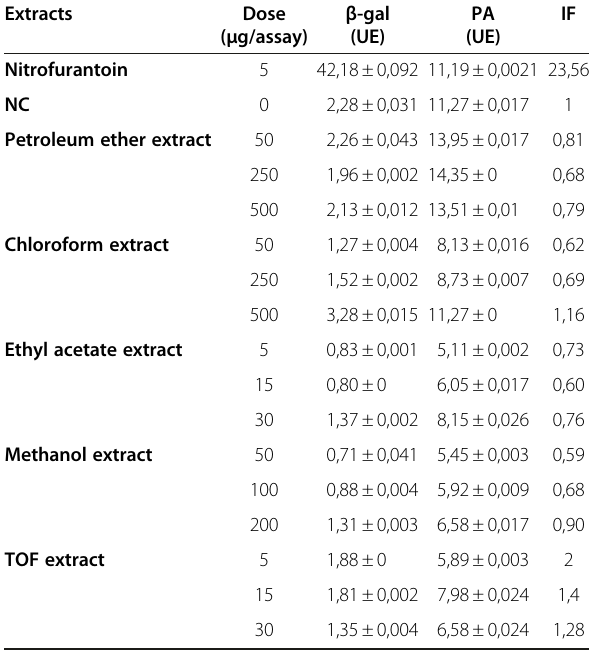
β -gal: units of β -galactosidase; AP: units of phosphatase alkaline; IF: induction factor. Positive control of genotoxicity (nitrofurantoin); NC: negative control (non- treated